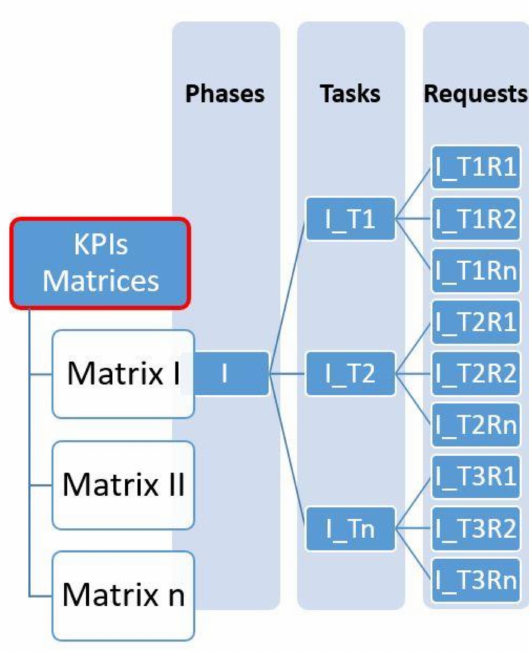
Figure 3. KPI matrices layout.